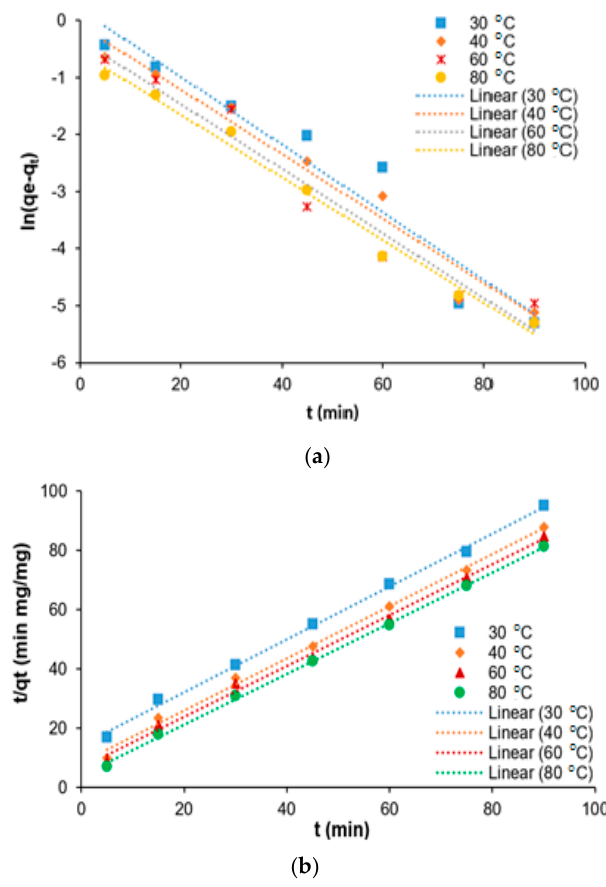
Figure 10. Adsorption kinetics studies for the removal of BOD from SRPE using FeSO 4 ·7H 2 O as a coagulant. ( a ) Pseudo-first-order kinetic model and ( b ) pseudo-second-order kinetic model.